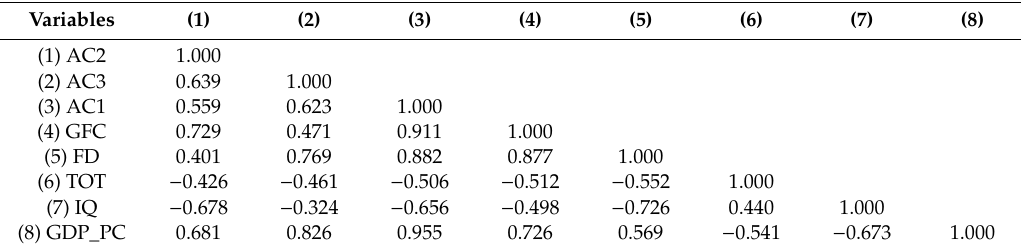
Table A1. Matrix of correlations (China).